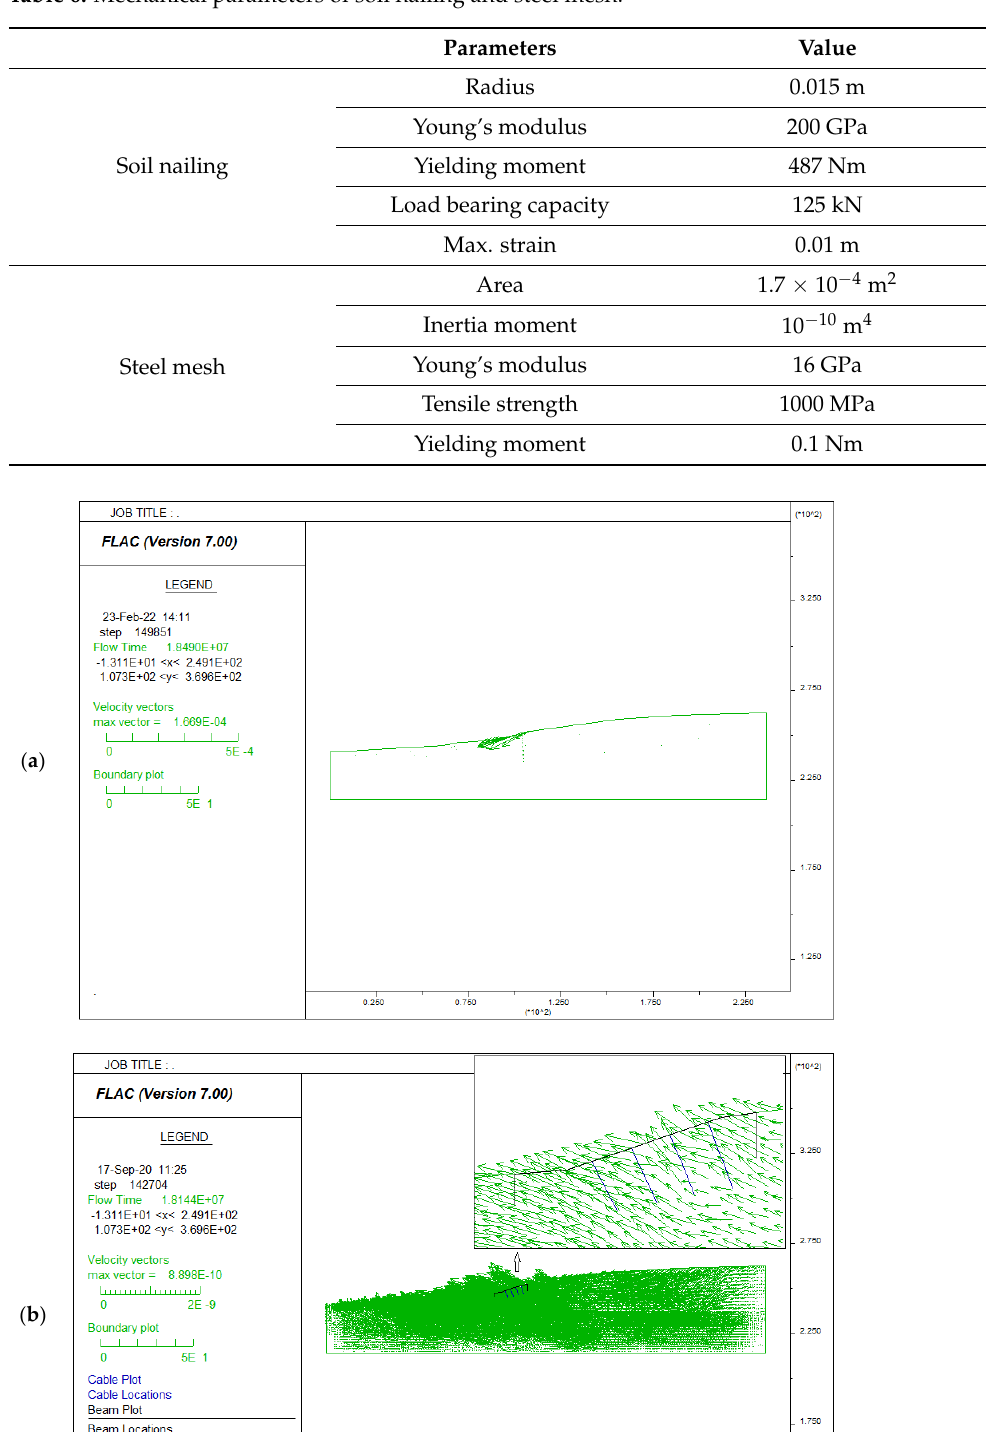
Table 6. Mechanical parameters of soil nailing and steel mesh.